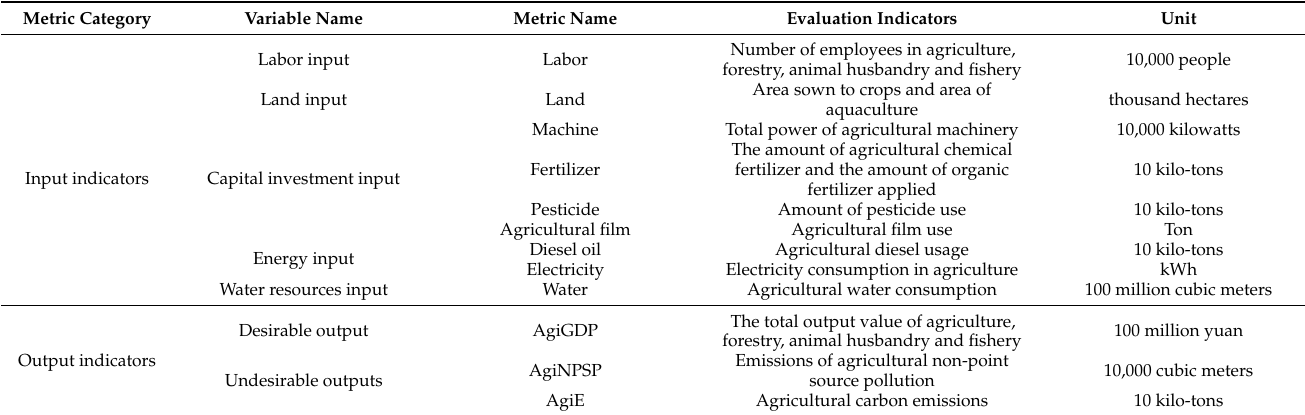
Table 1. Measurement index system concerning